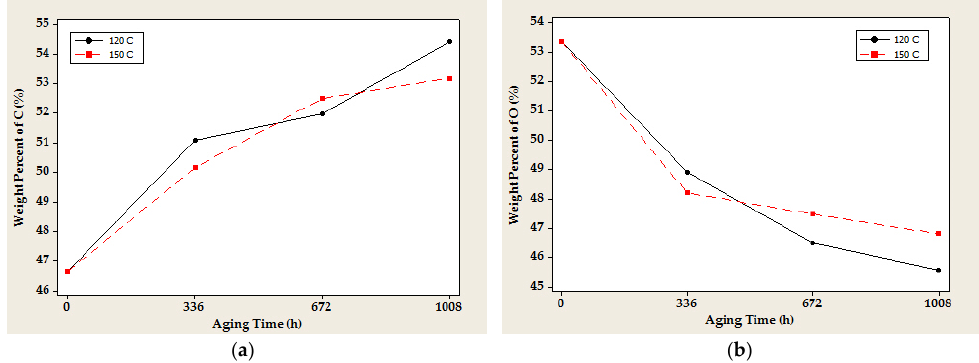
Figure 15. Weight percent of C and O elements of transformer insulation paper at aging temperature ( a ) 120 °C and ( b ) 150 °C.